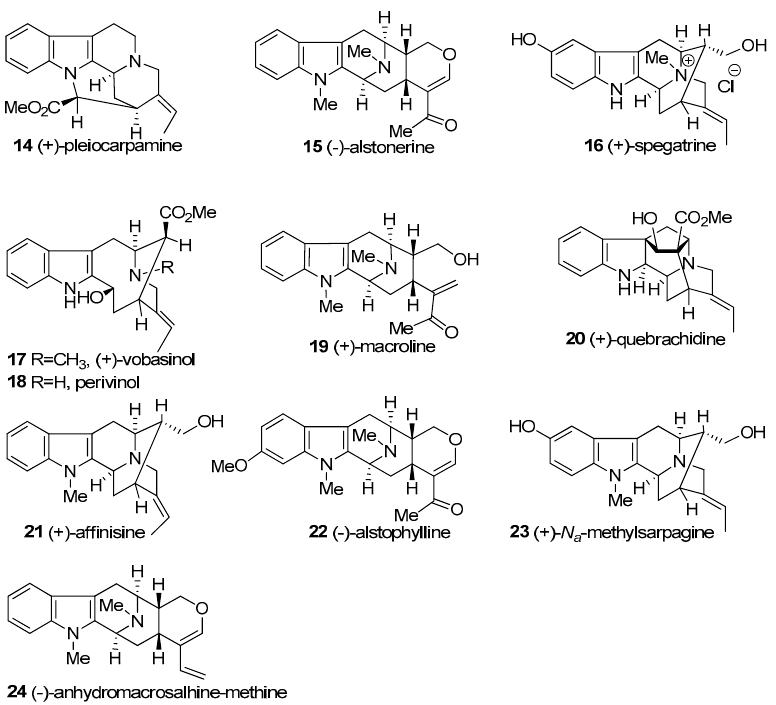
Figure 2. Monomeric units present in the bisindole alkaloids reviewed herein.